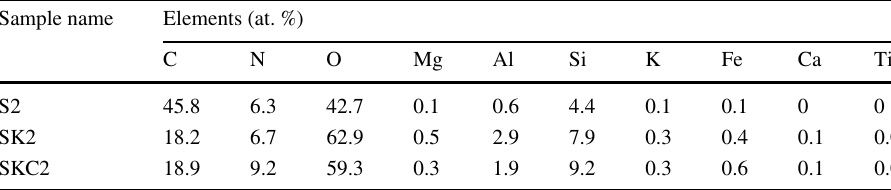
Sample name Elements (at. %)